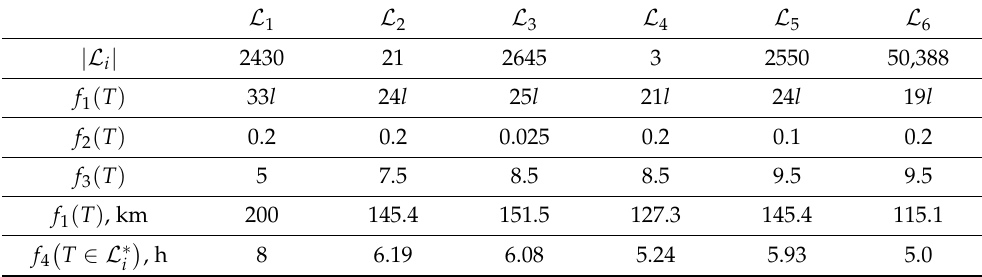
Table 4. Characteristics of Pareto-optimal routes from the set ℒ 𝑖 as illustrated in Figure 4a – f.